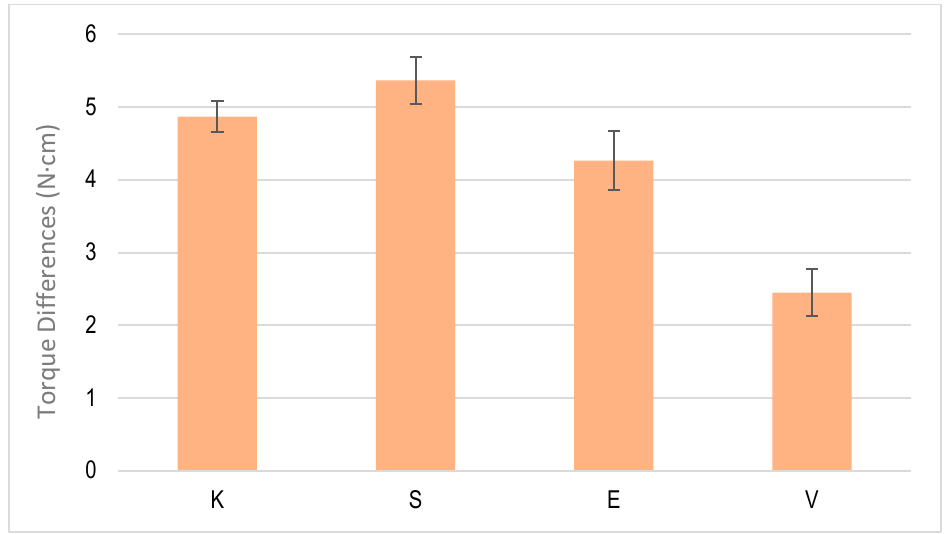
Figure 8. Torque differences for the cyclic test of tightening and untightening torque for each dental implant system.